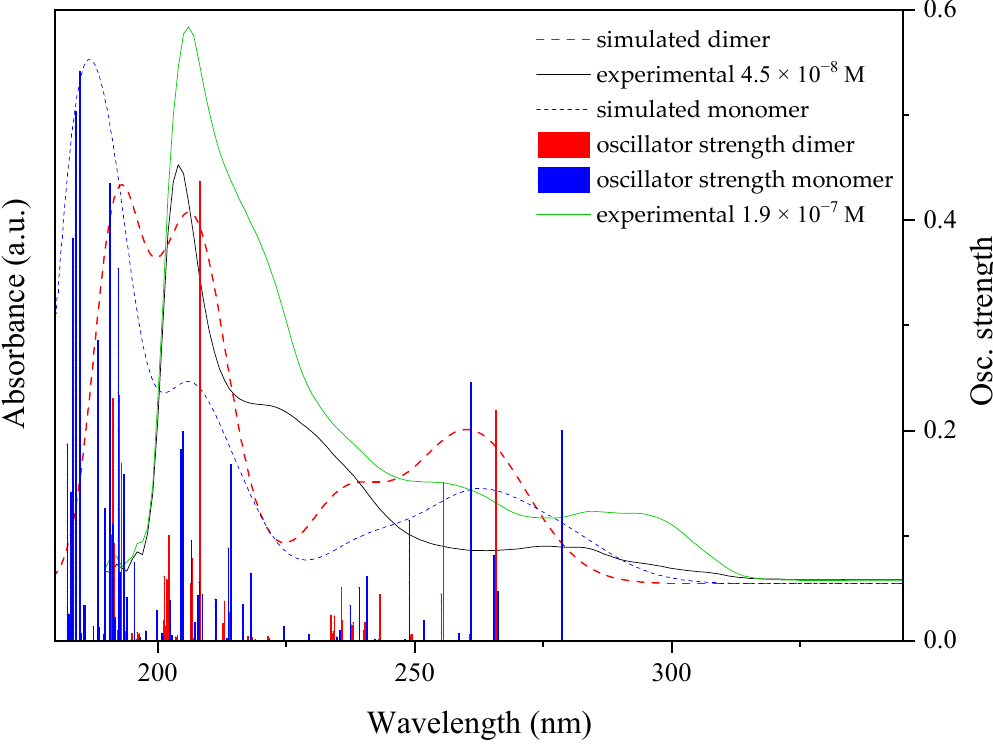
Figure 12. Experimental (black and green lines), calculated (dashed black and green lines) UV-Vis spectra and oscillator strengths of [Zn( μ -Pip)(Pip)(Isn) 2 ] 2 ·2[Zn(Pip) 2 (HPip)(Isn)]·2MeOH ( 2 ). The HOMO and LUMO orbitals of 1 – 4 have π symmetry, being the HOMO along the Pip ligand while the LUMO is localized over the 4-Acpy and Isn linkers. This MO seclu- incorporation of 4-Acpy ligand, bearing a more electron withdrawing functional group, would lower the energy of the LUMO and, thus, reduce the energy gap. The HOMO or- bitals of these complexes are quite similar in energy, ranging from − 8.312 eV to − 8.018 eV since they are all located over the Pip ligands. In opposite, the LUMO orbitals present a significant difference in energy, which can be sorted into three groups. The monomer in 2 has the higher energy LUMO of − 0.038 eV, while the dimers of Isn have values of − 0.407 eV ( 2 ) and − 0.535 eV ( 4 ), respectively. Finally, 1 and 3 dimers have the lowest energy LUMO with values of − 0.905 eV ( 1 ) and − 0.976 eV ( 3 ). The HOMO–LUMO gaps are be- tween 8.274 eV and 7.244 eV, with complexes 1 and 3 presenting the smallest values. The combined MOs (S.I.: Figures S18–S22) and NTOs (S.I.: Figures S23–S27) analysis of 1 – 4 reveals that less energetic electronic transitions of the spectra are based on local